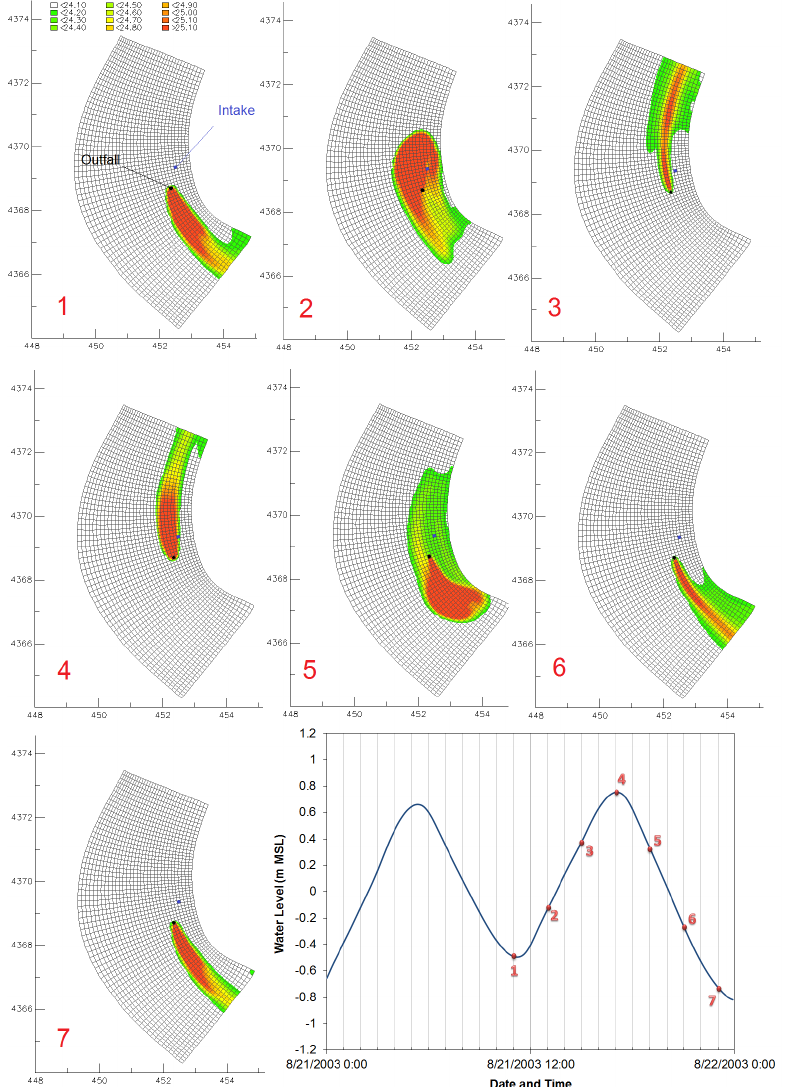
Figure 9. Thermal plume pattern during tide at the surface: Scenario